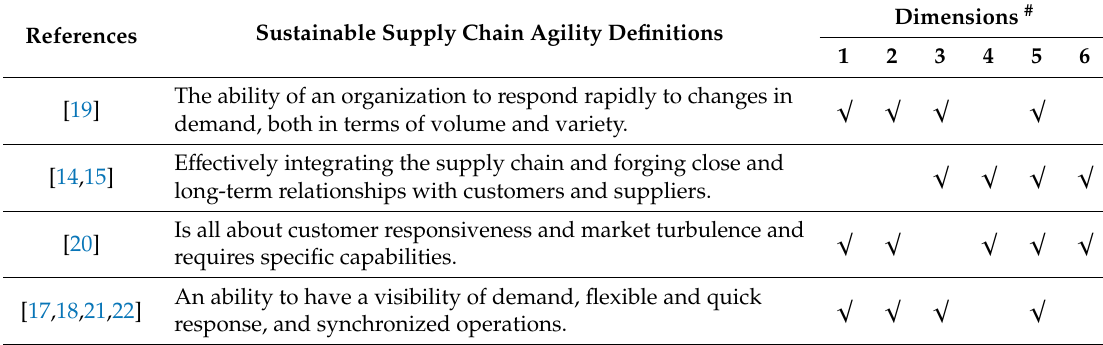
Table 1. Sustainable supply chain agility definitions and